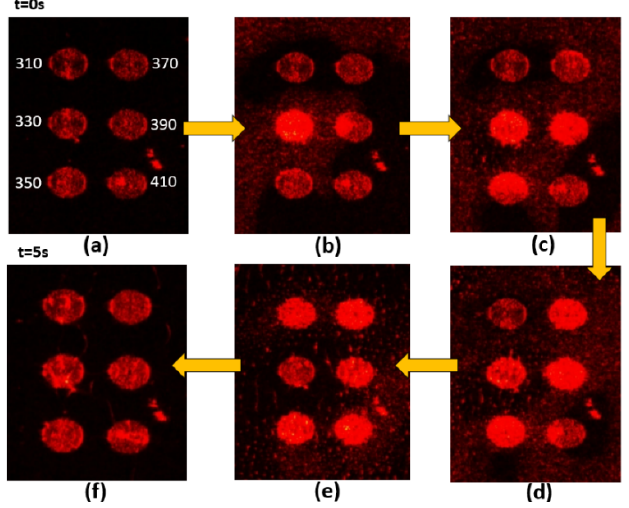
Figure 5. Sequential images from ( a ) to ( f ) illustrating transitional transmission through Al circular grating samples with pitches ranging from 310 nm to 410 nm. The pumping light is 532 nm. Liquid crystals are transformed from isotropic phase to nematic phase.